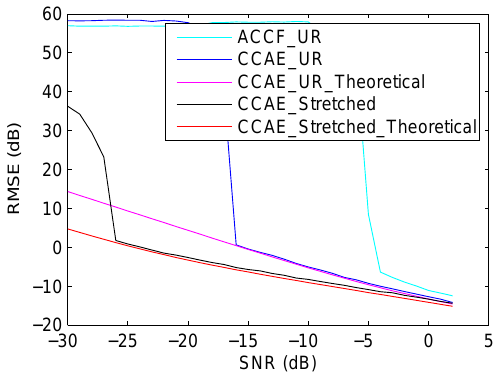
Figure 8. RMSE comparison of velocity estimation by using CCAE on stretched signals, CCAE on UR signals and ACCF on UR signals (with